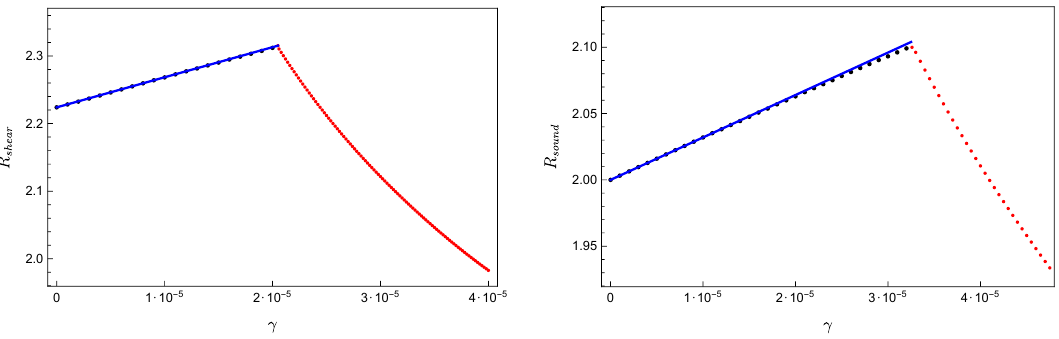
Figure 1 . Radii of convergence R shear and R sound of the hydrodynamic shear (left panel) and sound (right panel) modes in the N = 4 SYM theory as a function of the coupling γ ∝ λ − 3 / 2 . Solid blue curves correspond to the perturbative results of eqs. (1.7), (1.8), black dots are the non-perturbative results. The red curves are determined by the level-crossings of the hydrodynamic modes with the modes not present in the perturbative